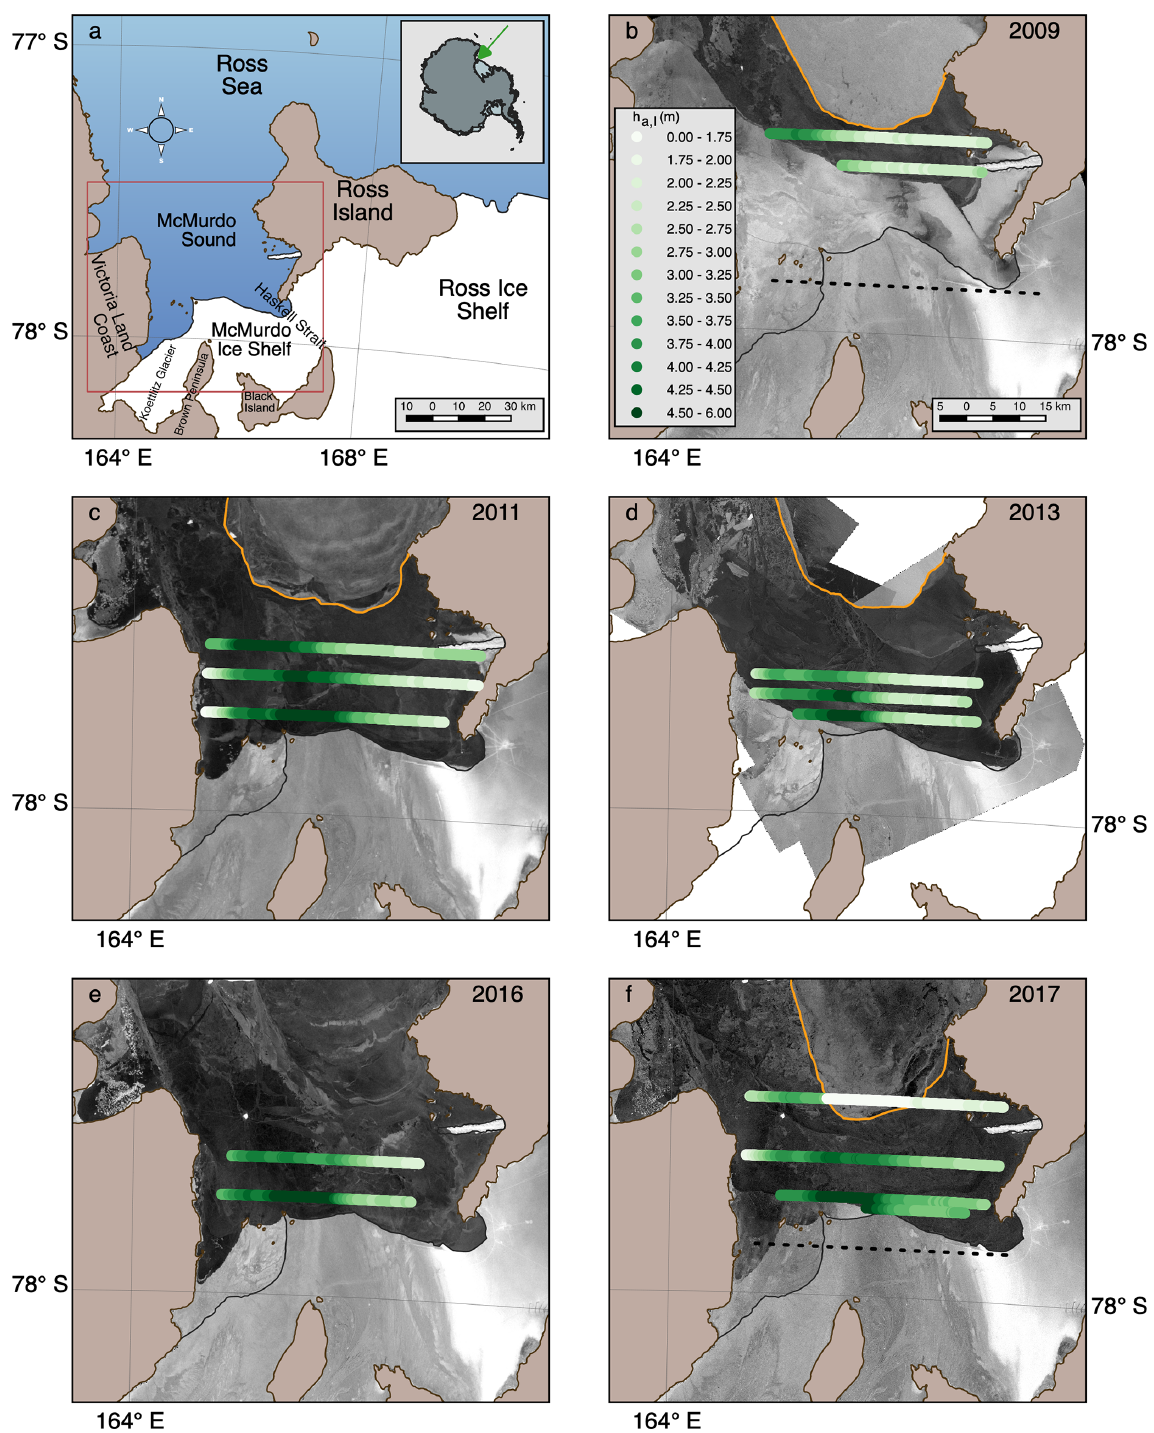
Figure 1. Overview maps of the AEM surveys carried out in 2009, 2011, 2013, 2016, and 2017. (a) Regional overview and the location of McMurdo Sound (green arrow) and boundaries of satellite images (red). (b–f) Locations of east–west profiles, overlaid on synthetic- aperture radar (SAR) satellite images to show differences in general ice conditions and ice types (Brett et al., 2020; 2009/11: Envisat; 2013: TerraSAR-X; 2016/17: Sentinel-1). Colours correspond to different apparent ice thicknesses h a ,I (Sect. 2.1.2). Orange lines mark respective fast ice edges. Bright areas to the south are the McMurdo Ice Shelf. Black dashed lines in (b, f) show tracks of ice shelf thickness surveys used in Figs. 10a and 11 (Rack et al.,